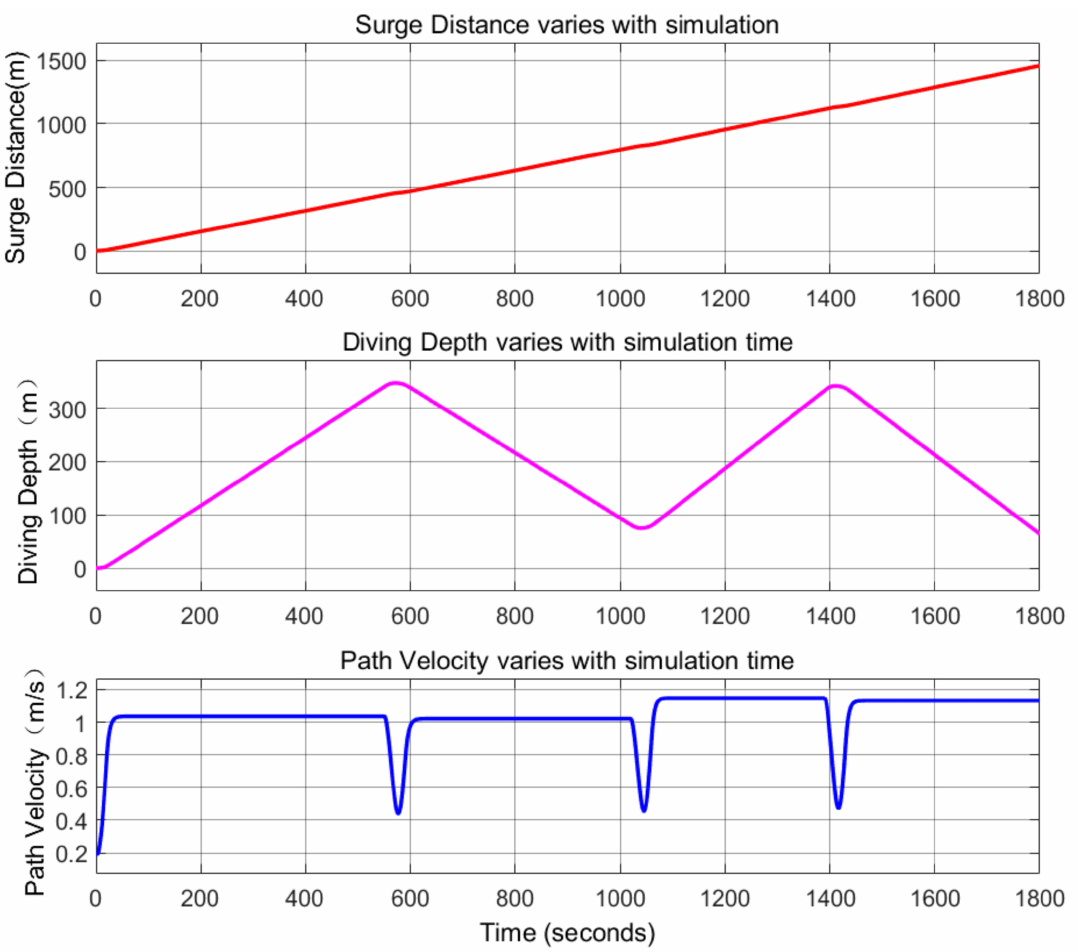
Figure 8. Surge, diving, and path velocity varying with simulation